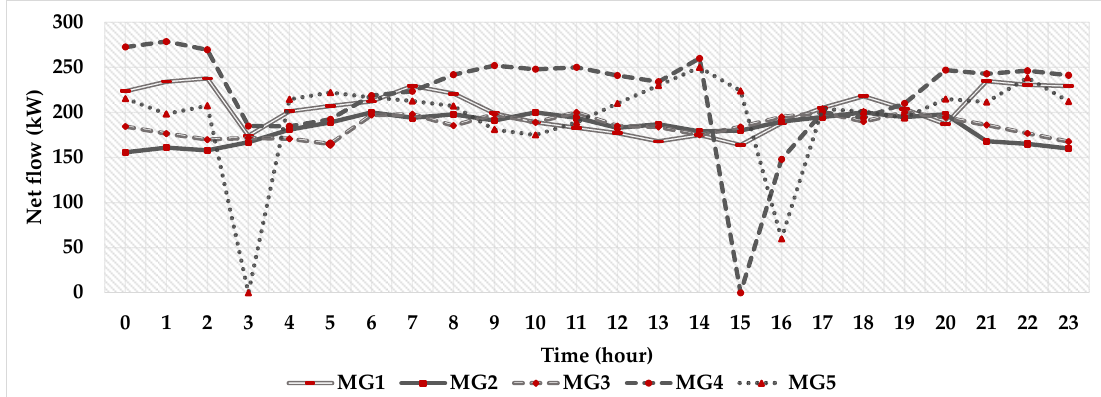
Figure 10. Equivalent net flow of the MGs for the electricity bill calculation considering power sharing.